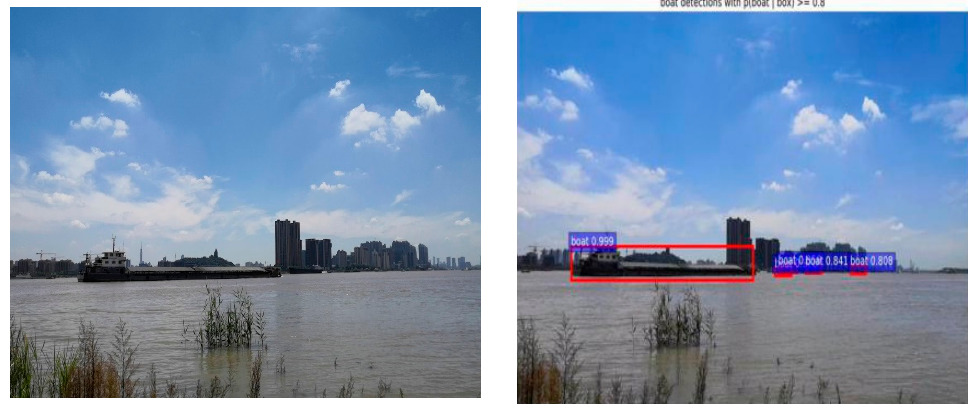
Figure 14. Test diagram of this method.